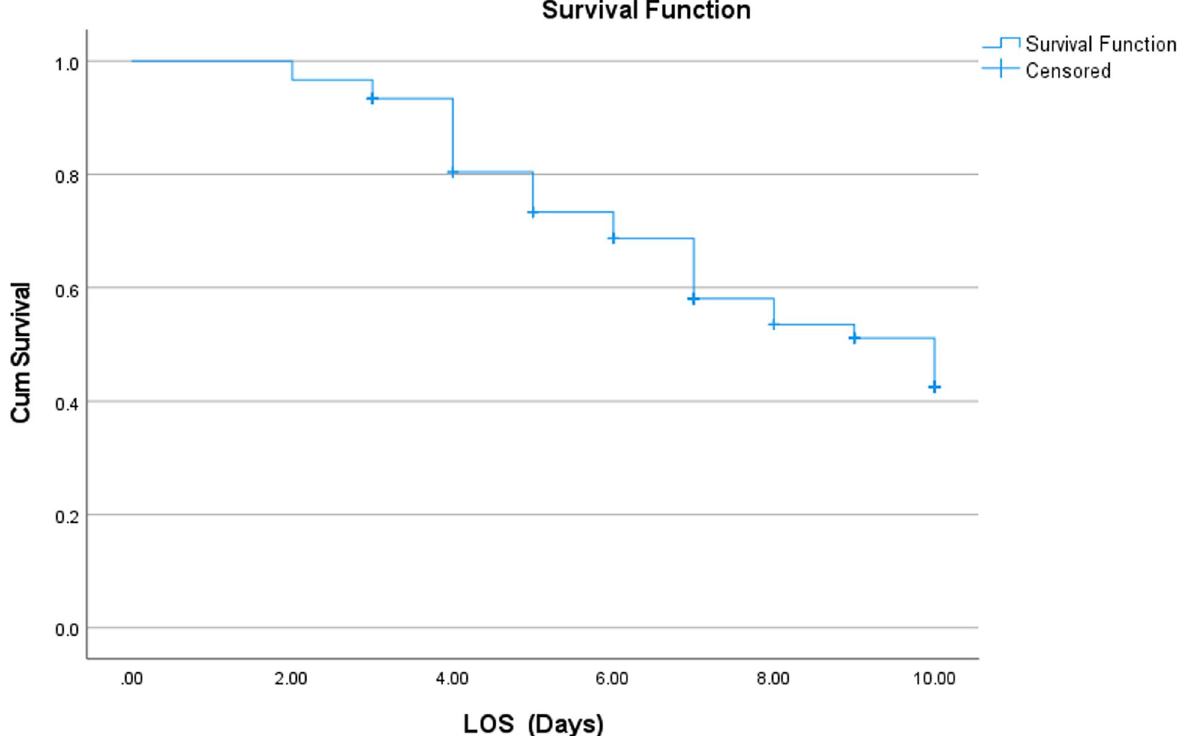
Fig. 1 Kaplan–Meier survival curve for the length of stay till death for